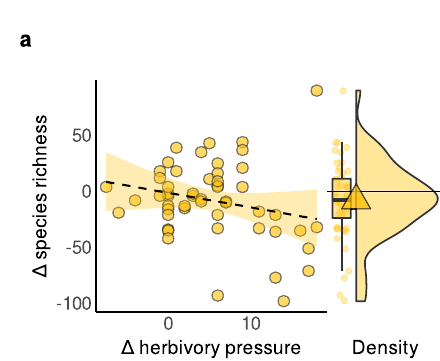
Fig. 3 | Herbivory increased temporal species turnover but was not clearly associatedwithchangesinspeciesrichness. Relationshipsbetweenchangein( Δ ) herbivory pressure and a Δ species richness (number of species) and b temporal species turnover (unitless) at a study site. All models included inter-census time span, site area, and baseline herbivory as covariates, with n =52 independent res- urvey sites. Lines and ribbons represent the posterior mean line and the 95%